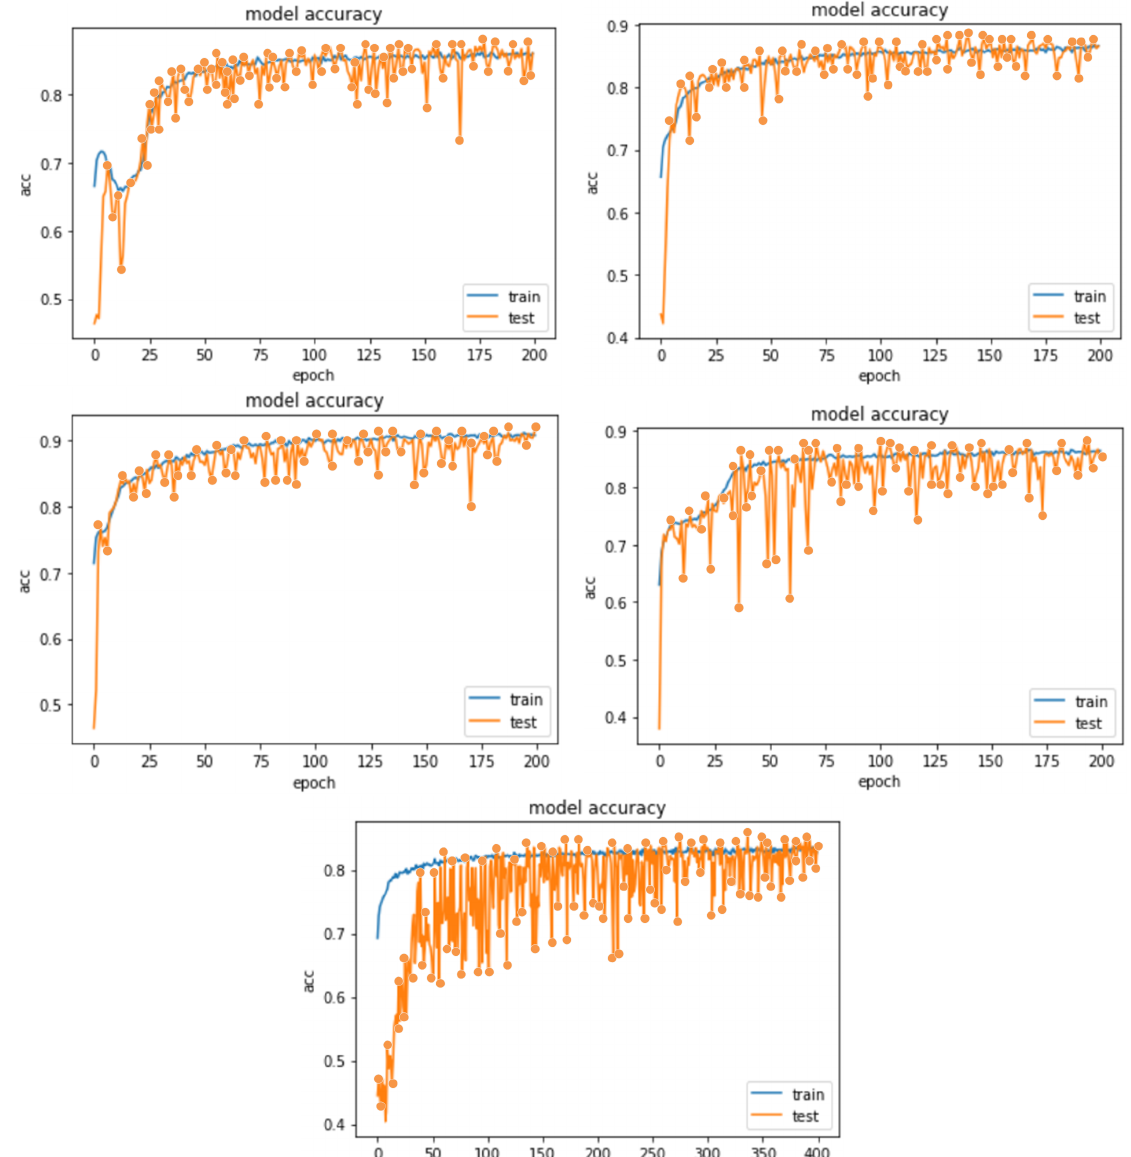
Figure 7. The training accuracy qualities of the double-layer ANN for the two classes for the set of indicators from the ATC profile widths at levels of 10%, 30%, 50%, 70% and 90% of the maximum amplitude value and maximum amplitude with heights separation.